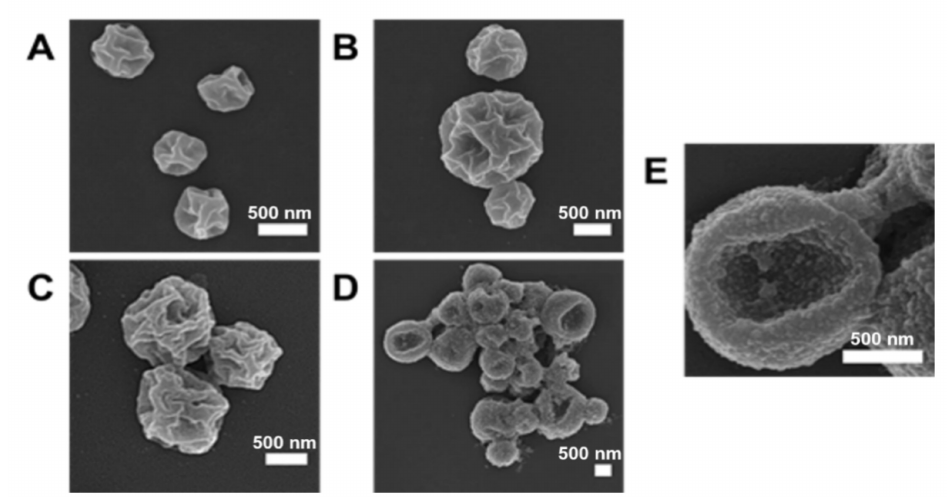
Figure 4. SEM micrographs for structures formed when a thermally annealed solution of HByp4 (250 µ M, 10 mM HEPES pH 7.0) was treated with 250 µ M of ( A ) Co(ClO 4 ) 2 ( B ) Cu(ClO 4 ) 2 ( C ) Zn(ClO 4 ) 2 , and ( D , E ) RuCl 3 . Scale bars: 500 nm.